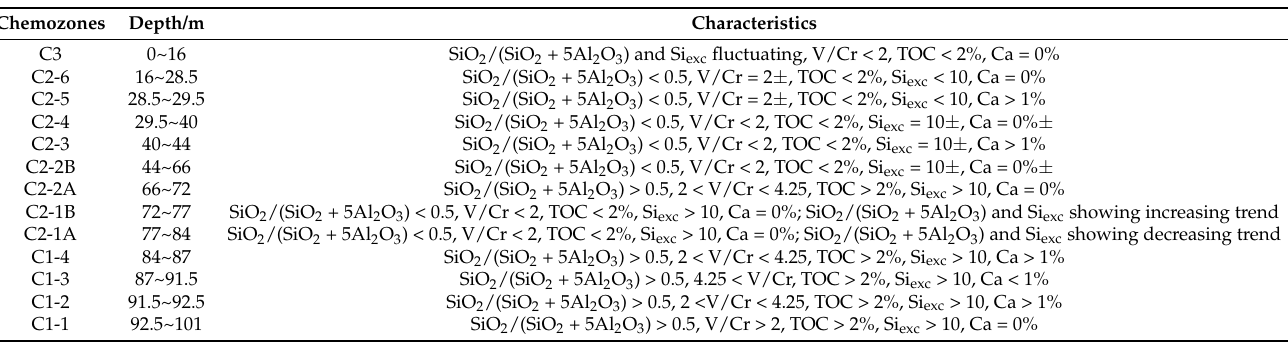
Table 3. The geochemical characteristics of